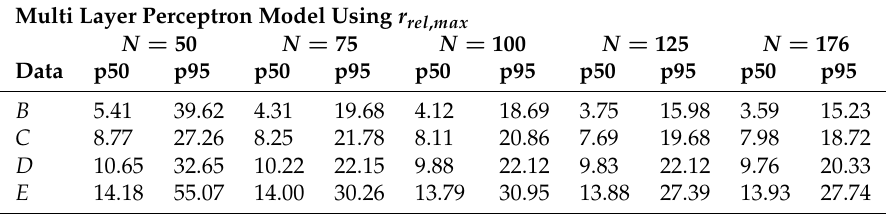
Table 7. The p50 and p95 percentiles of the error expressed in (cm) for the Multilayer Perceptron model. Multi Layer Perceptron Model Using r rel ,